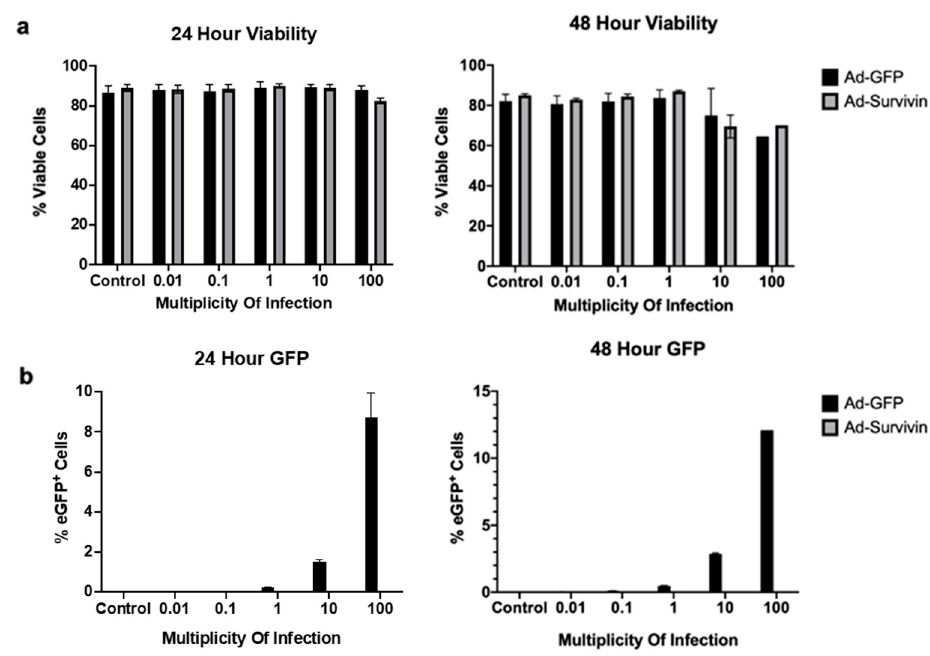
Figure 4. Ad-T34A-mSurvivn was not cytotoxic to antigen-presenting cells. Female C57BL/6 bone- marrow-derived APCs were cultured for seven days with GM-CSF and IL-4. After seven days, the cells were seeded into a 96-well dish at a concentration of 2.5 × 10 5 cells per well. Each well was treated with either media only (control) or a range of multiplicities of infection with the Ad-eGFP vector or the Ad-T34A-mSurvivin vector. Two timepoints were independently evaluated for ( a ) vi- ability by staining with 7AAD and ( b ) eGFP expression via flow cytometry. Experiments were re- peated five times. Means and standard errors are shown.